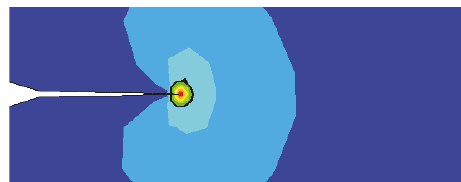
Figure 14: Plastic zone with 5.79mm